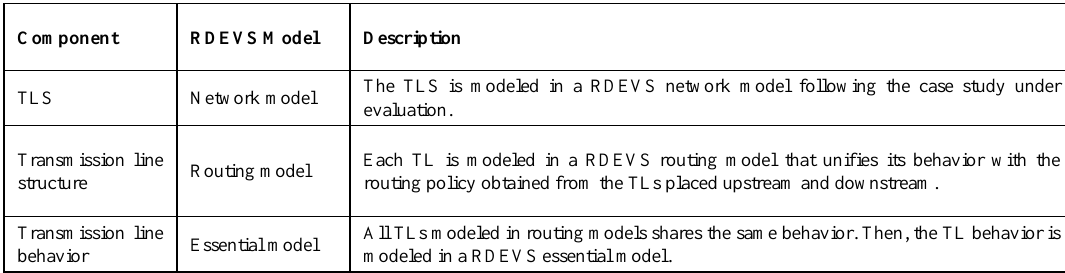
Table 1. RDEVS models used for the M&S of